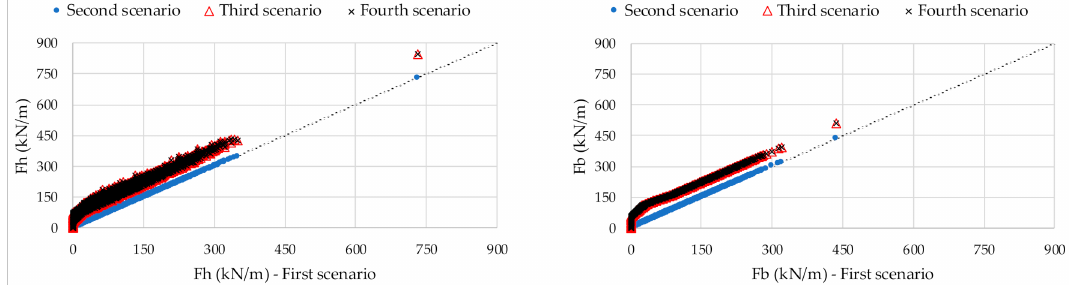
Figure 18. Horizontal and vertical forces for the first scenario compared with the second to fourth scenarios— Nørgaard et al.